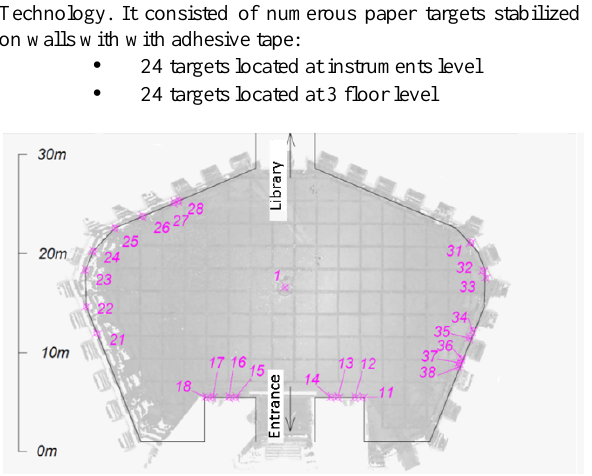
Figure 3. Test field (scanner-level targets